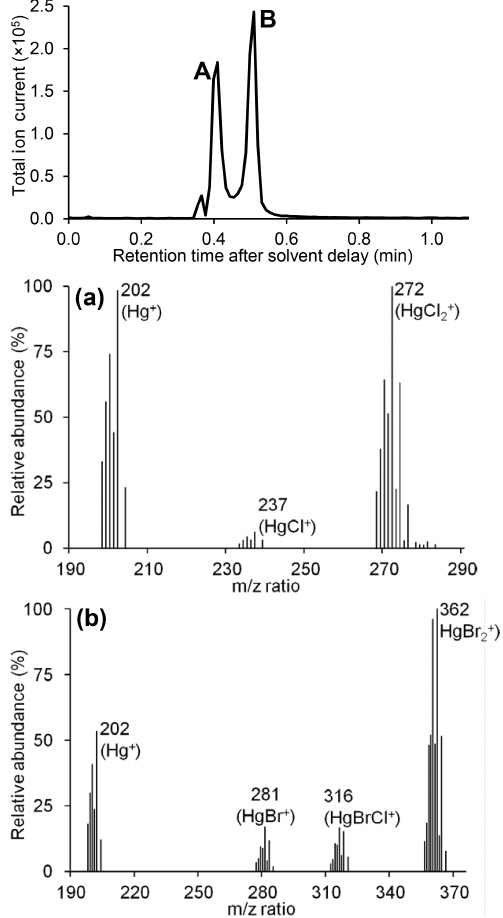
Figure 2. Chromatogram of a mixed standard of HgCl 2 and HgBr 2 in acetone (0.5mugµL − 1 for each compound) (top), mass spectra for HgCl 2 ( b , middle) and HgBr 2 ( b , bottom). Solvent delay was